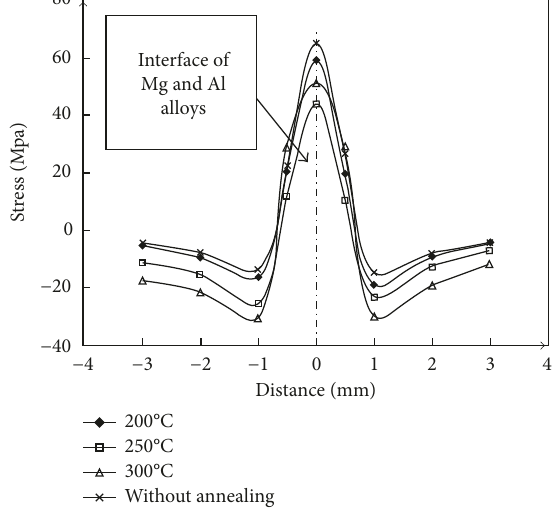
Interface of Mg and